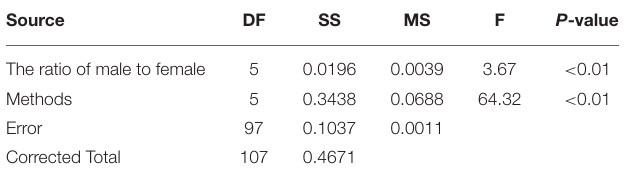
TABLE 8 | Variance analysis of the ratio of male to female on the accuracy of GEBV for live body weight.